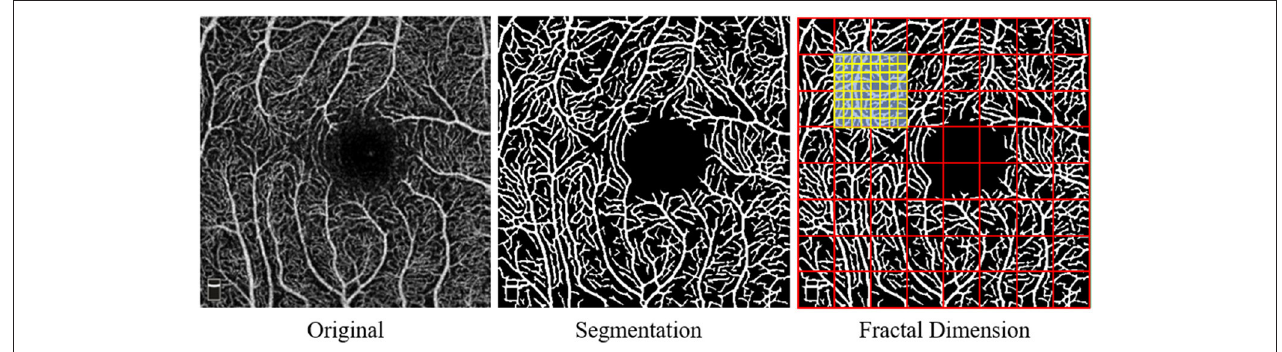
FIGURE 1 | Display of the macular capillary plexus and its quantitative analysis using fractal dimension (FD).